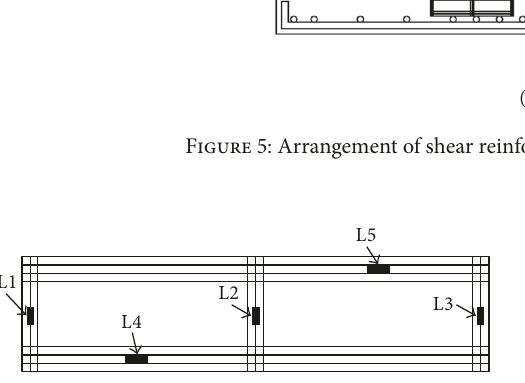
Figure 6: Strain gauge locations on the GFRP plate in the GC-184 specimen.